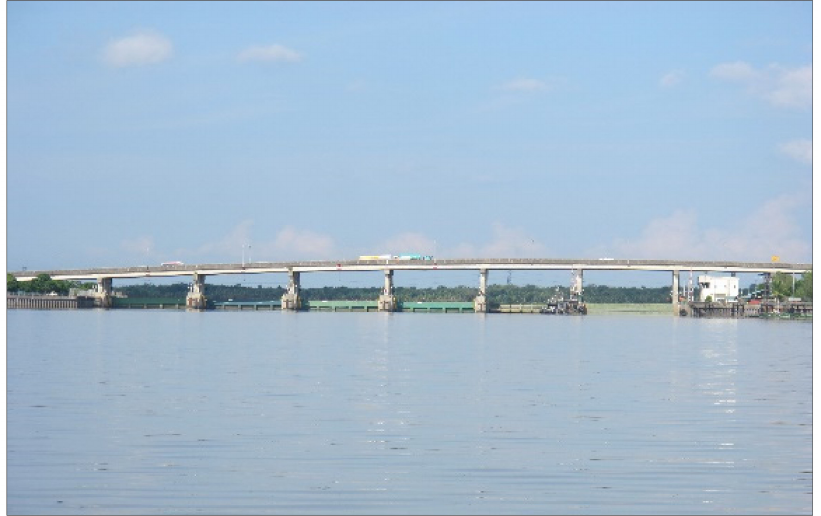
Figure 22. The tidal barrier to prevent seawater intrusion impact, Sarawak [142]. Reprinted from Saline Water Intrusion through Rajang River Network due to Sea Level Rise, 2019; open access publication by IOSR